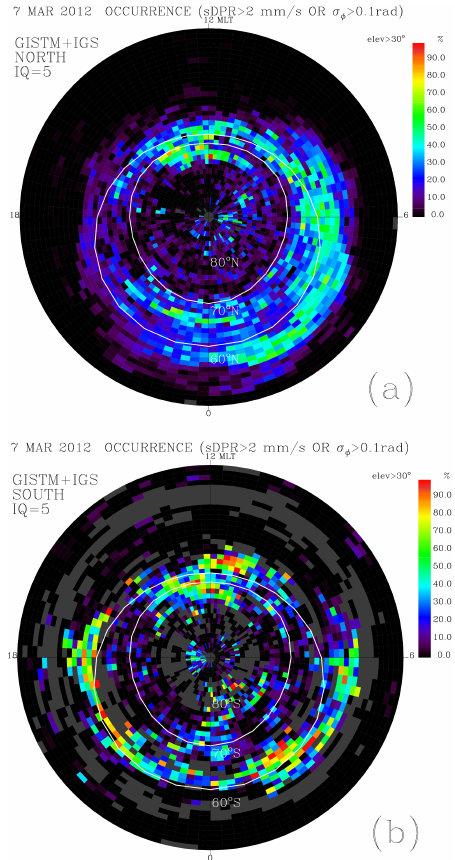
Figure 7. The composite maps of phase scintillation combining the occurrence of sDPR>2mms − 1 and σ (cid:56) >0.1rad in the (a) northern and (b) southern high latitudes on 12